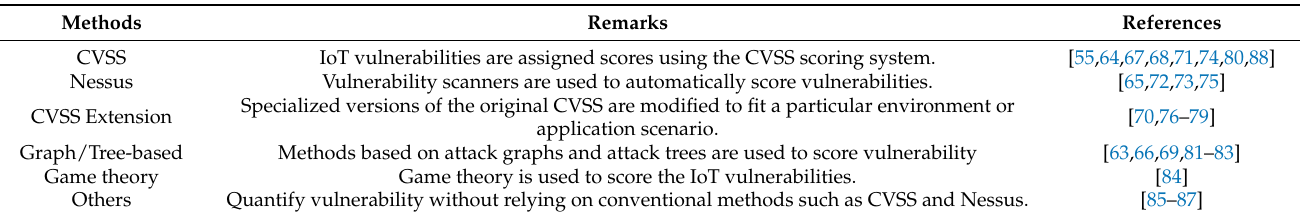
Table 6. Vulnerability score assessment methods.